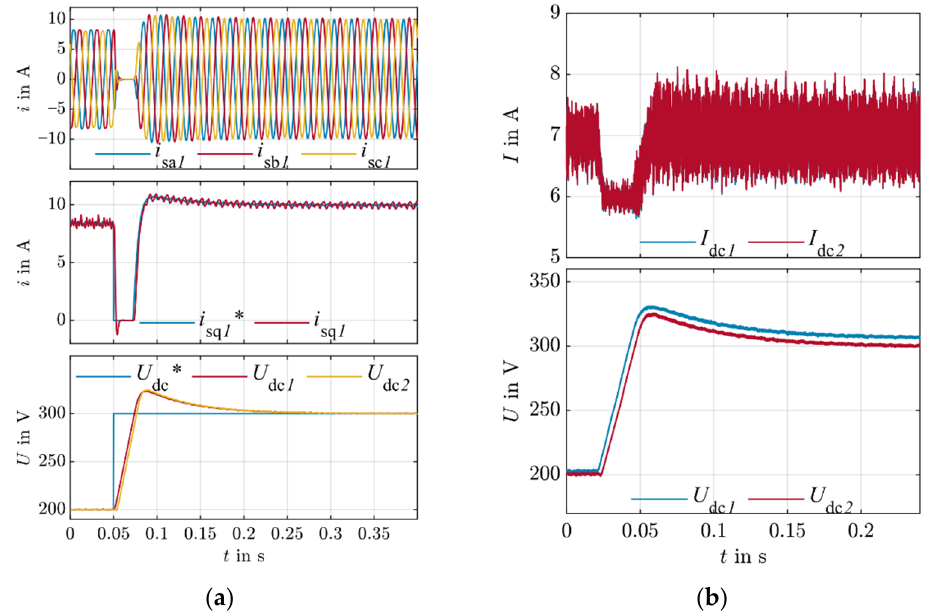
Figure 5. Voltage setpoint change from 200 V to 300 V at 10 A load condition; ( a ) Control unit recordings; ( b ) Oscilloscope recordings.